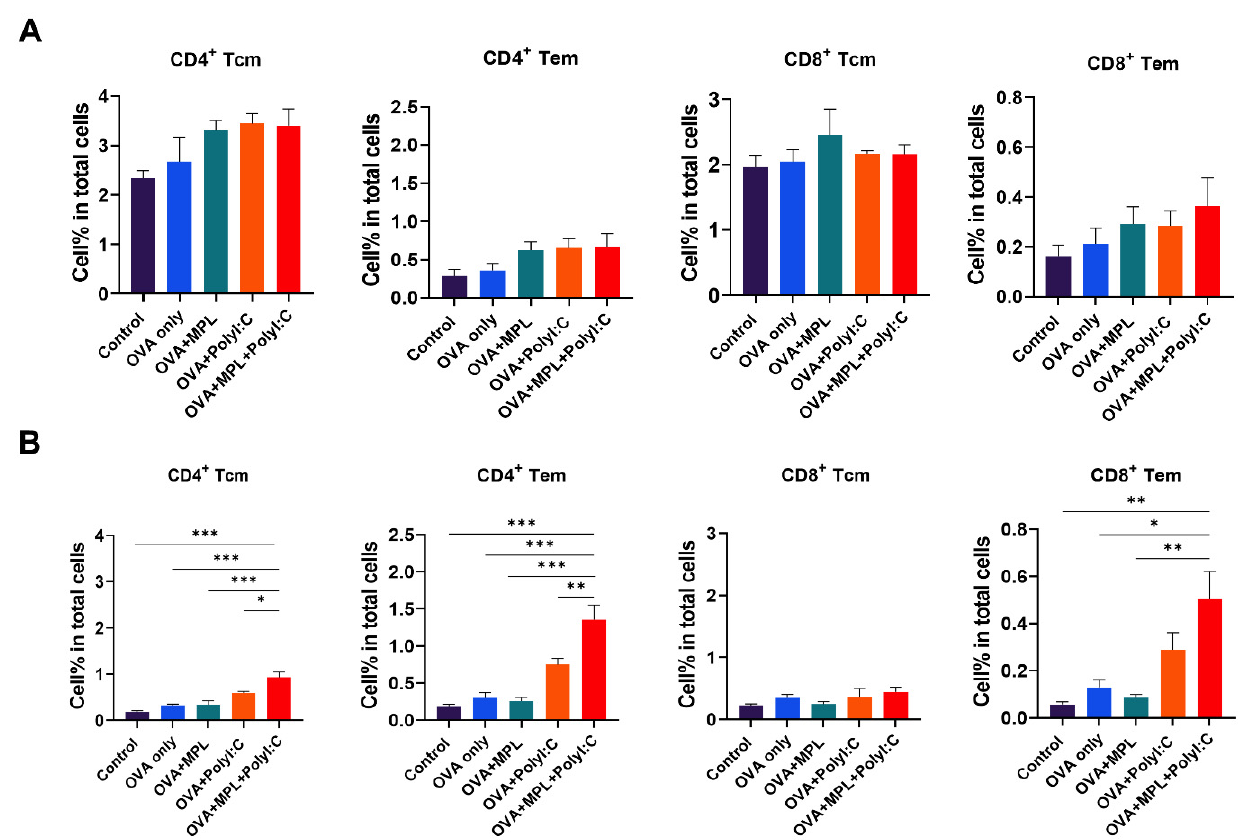
Figure 5. Memory T cell frequencies after immunization. The Tcm and Tem frequencies of CD4 and CD8 T cells in lungs ( A ) and spleens ( B ) after immunization were determined by flow cytometry. Lung and spleen cells were harvested from the mice 2 weeks after boost immunization. All results were shown in mean ± SEM. For statistical analysis, One-way ANOVA and Tukey’s post-multiple comparison tests were performed. * p < 0.05; ** p < 0.01; and *** p < 0.001 between the indicated groups.